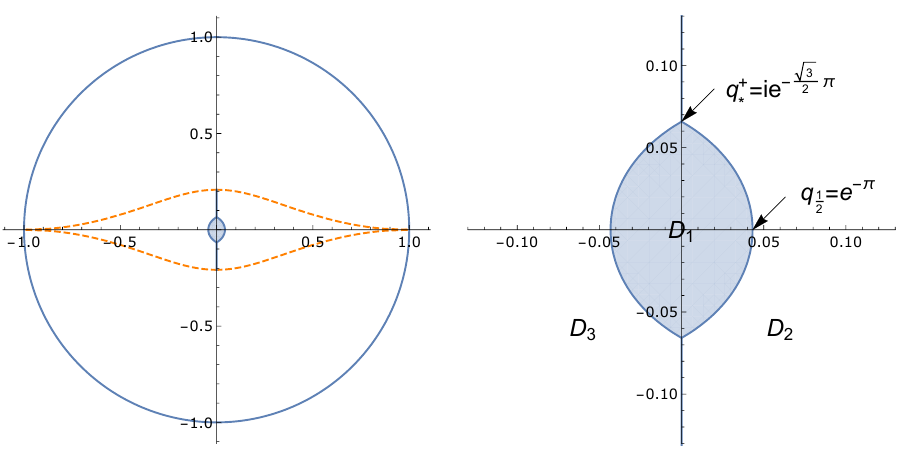
Figure 3 . The eye-shaped region bounded by the dashed line is the range of q ( z ) under one branch of the q -map (B.2) . The regions D 1 , D 2 and D 3 each contains two fundamental domains of the S 3 crossing symmetry group. See appendix